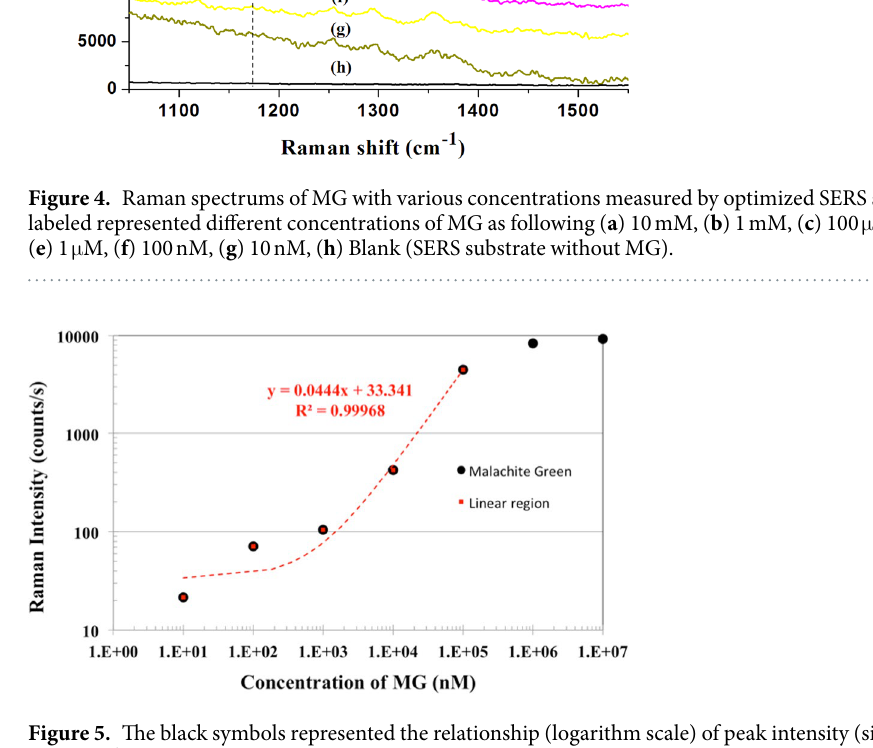
Figure 5. The black symbols represented the relationship (logarithm scale) of peak intensity (sited around 1176 cm − 1 ) and various concentration of MG measured by the optimized SERS substrate. The red symbols represented the linear region of quantitative measurement. It is noted that the laser setup is the same as previous Raman